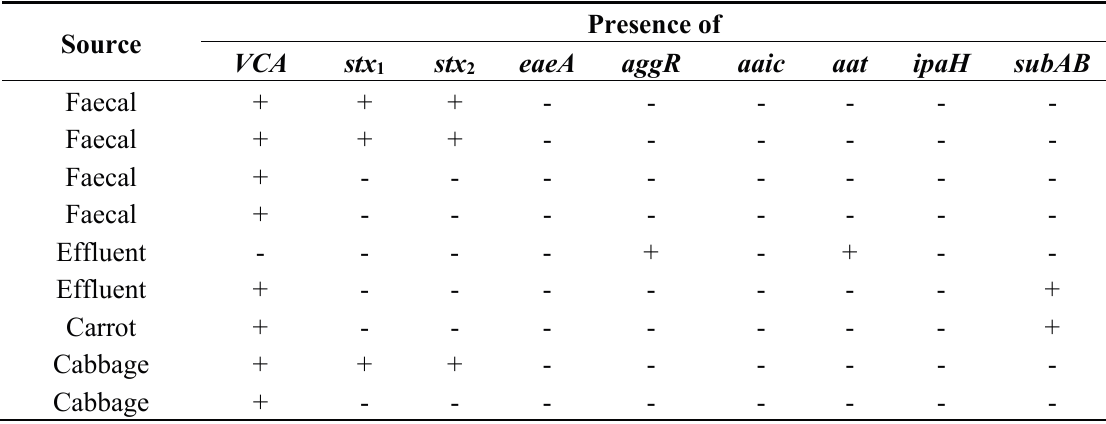
Table 2. Characterization of the pathogenic E. coli strains by PCR, and Vero Cell